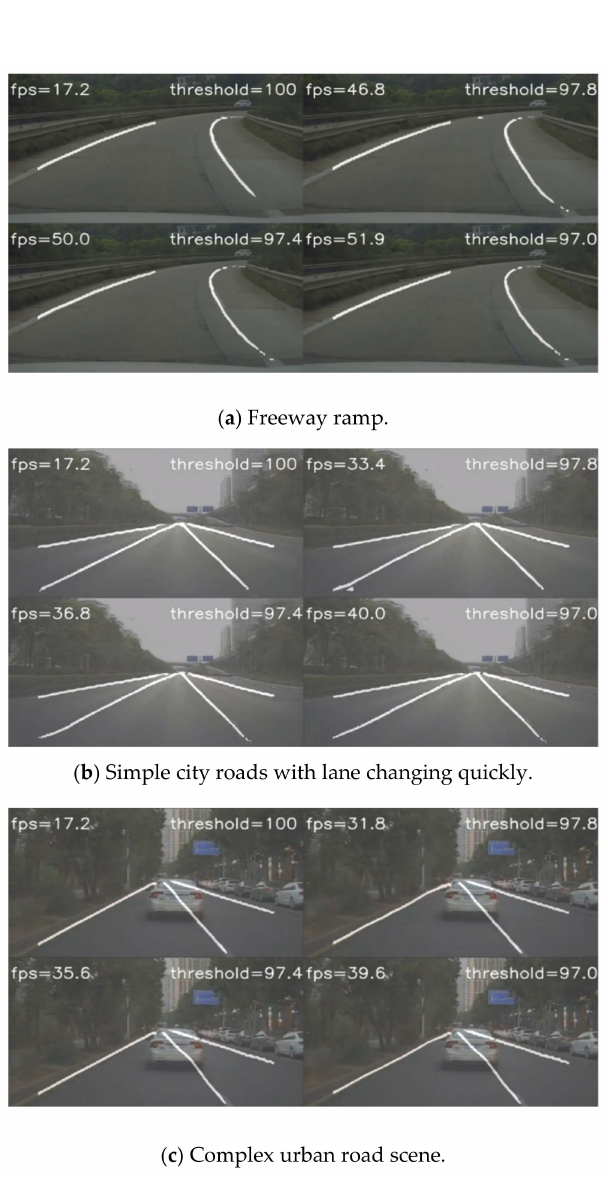
Figure 14. Compared with segmentation